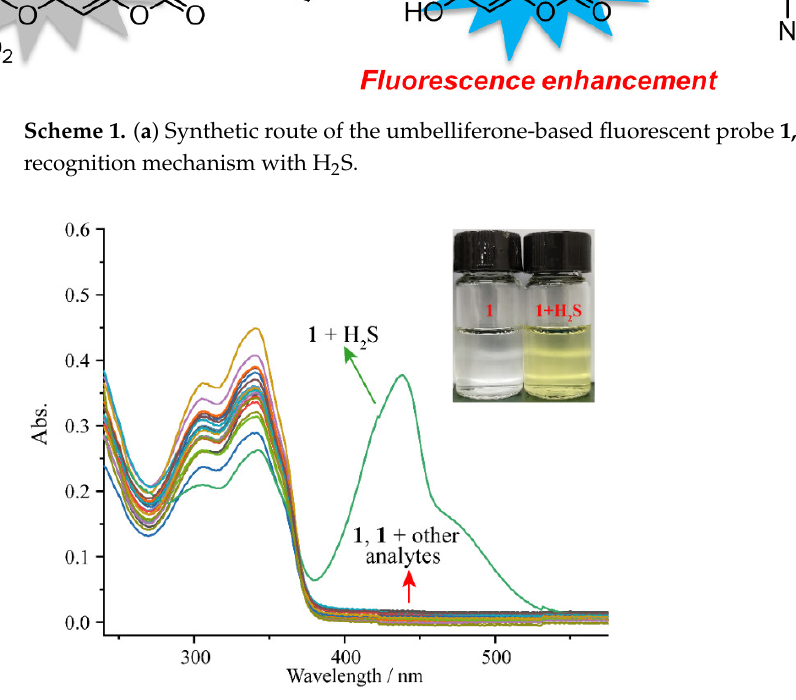
Figure 1. Absorption spectra of 1 (10 μM) treated with various analytes (10 equiv.) in CH 3 CN. The inset was the corresponding color change of 1 following the addition of H 2 S under visible light.